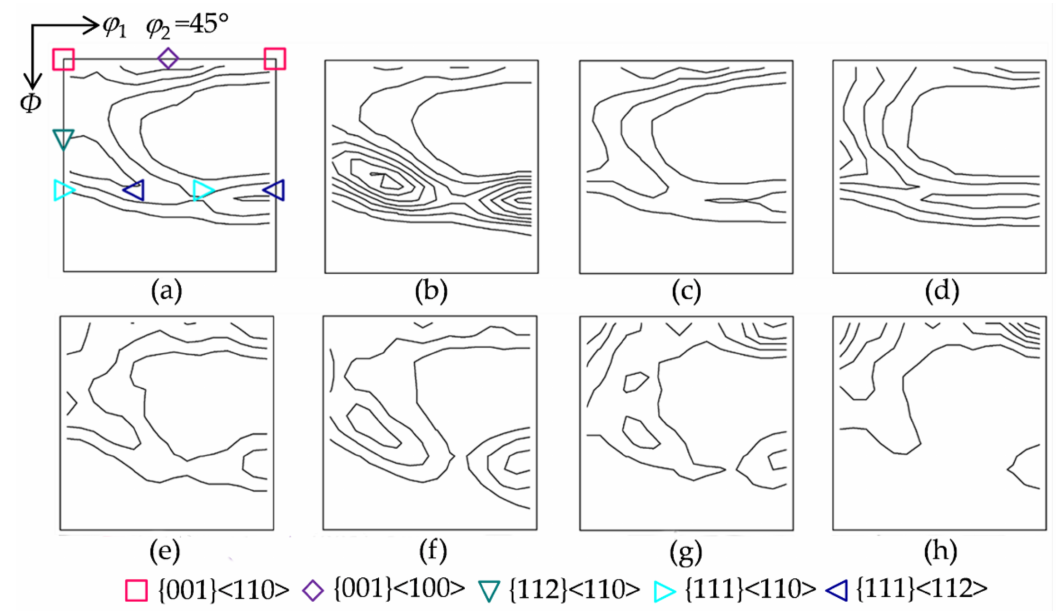
Figure 5. Constant ϕ 2 = 45 ◦ section of the ODFs (levels: 1, 2, 3 . . . ) under two hot deformation conditions, 900 ◦ C with 5 s − 1 ( a – d ) and 1150 ◦ C with 1 s − 1 ( e – h ), for four initial textures: ( a , e ) initial texture I, ( b , f ) initial texture II, ( c , g ) initial texture III, and ( d , h ) initial texture